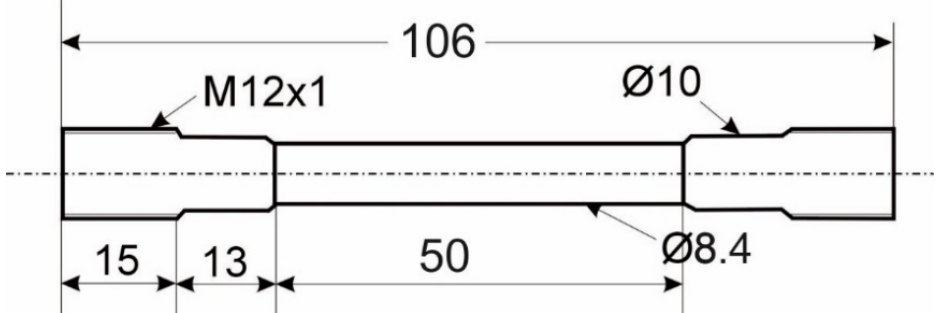
Figure 2. Design of the applied